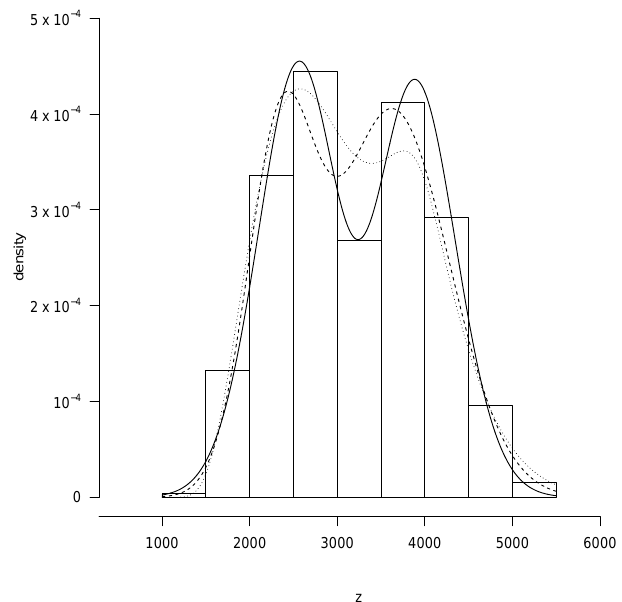
Figure 3. Models fitted by the ML approach for the fetal weight in grams data set: BSN (solid line), MN (dashed line) and FSN (dotted